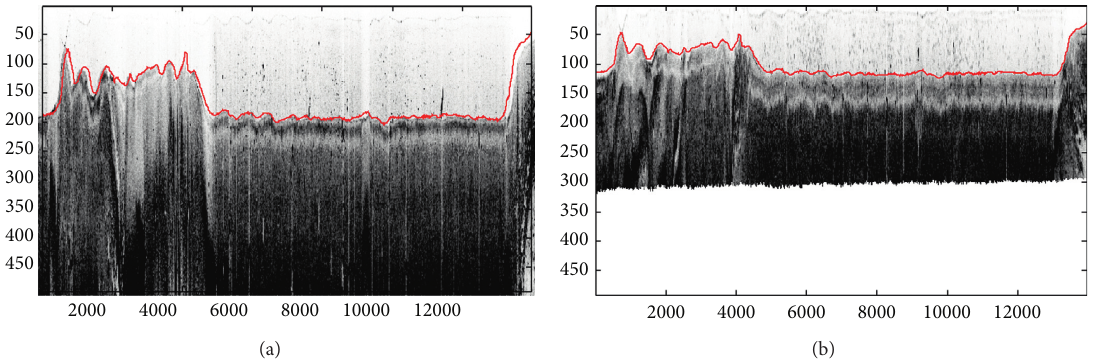
Figure 8: Detected sea bottom line marked separately on the port and starboard sides without showing the blind zone: (a) port side and (b) starboard side.